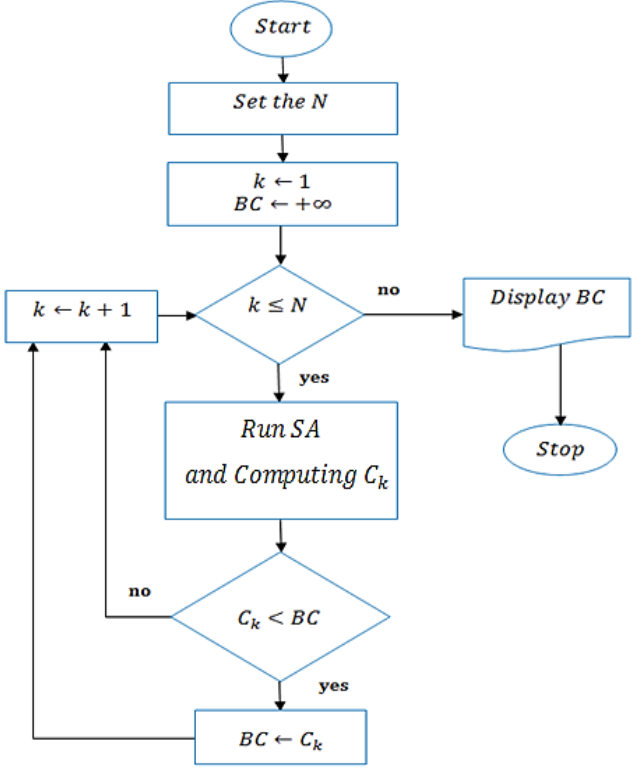
Figure 2. Developed simulated Annealing flowchart